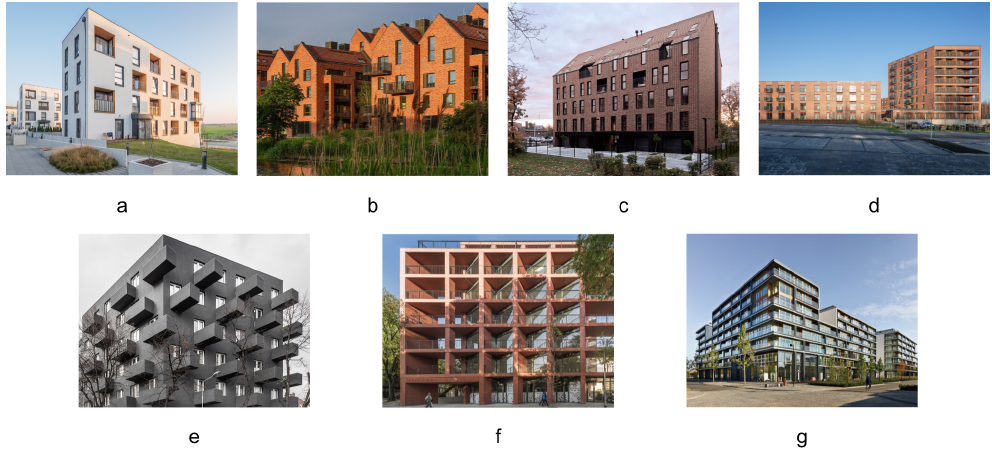
Figure 1. Polish residential, multi-family projects nominated for the Mies van der Rohe for 2011–2021: ( a ) Atmosfera real estate; ( b ) Riverview real estate; ( c ) Nowy Werdon building; ( d ) Nowy Nikiszowiec real estate; ( e ) Unikato building; ( f ) Sprzeczna 4 building; ( g ) 19 Dzielnica real